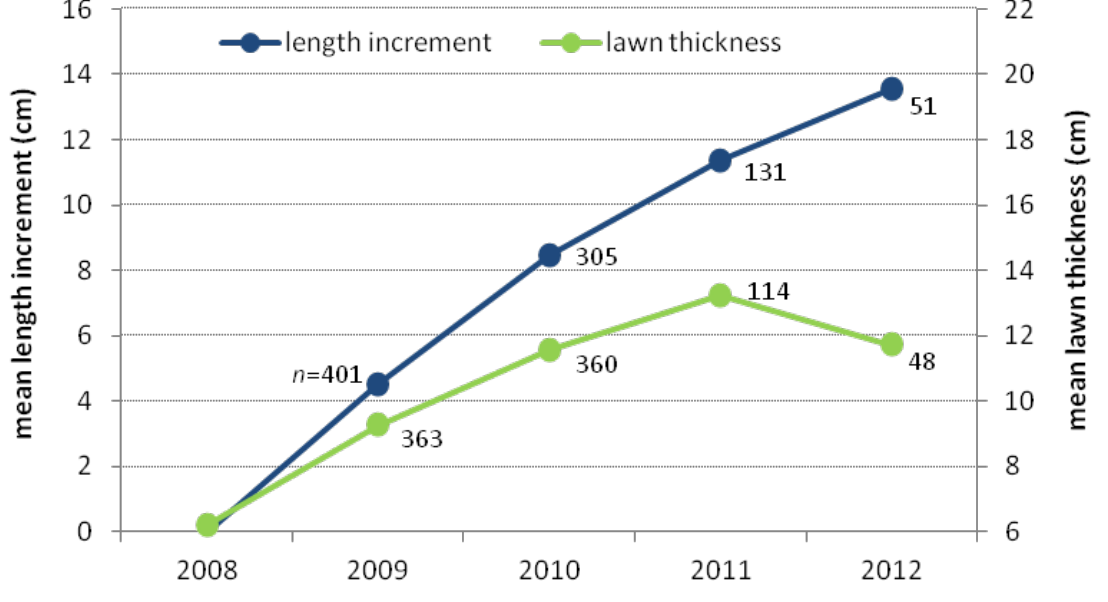
Figure 9. Mean cumulative length increment and mean lawn thickness of Sphagnum papillosum (in cm, mean thickness 6.2 cm in August 2008) at the study site between 2008 and 2012. Number of samples ( n ) for each measurement is written next to the mean value.